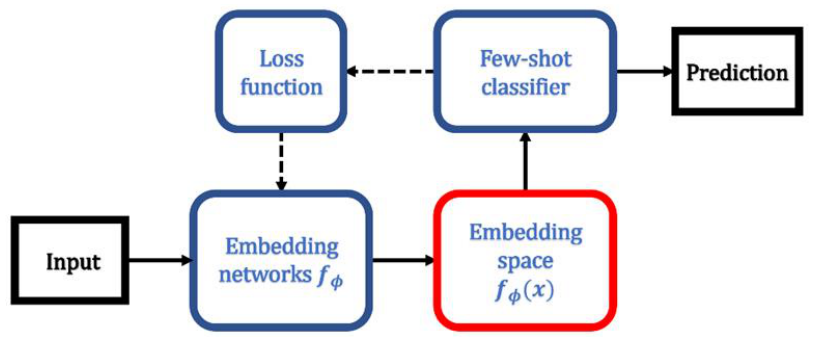
Figure 1. The overall structure of the metric-based few-shot classification model.